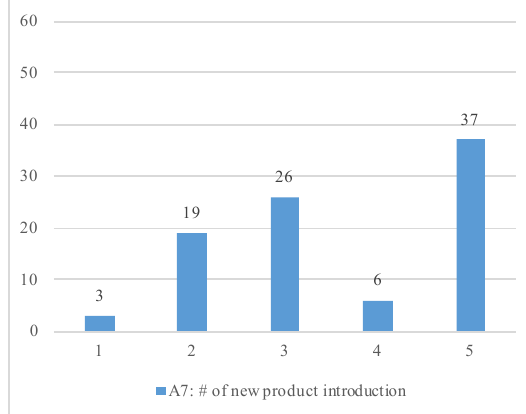
Figure 1. Frequency distribution of A7